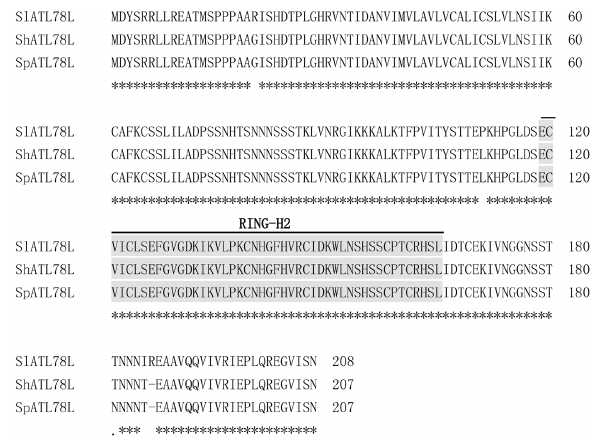
FIGURE 1 | Alignment of ATL78L amino acid sequences from Solanum lycopersicum cv. Ailsa Craig, S. habrochaites LA1777 and S. pennellii LA0716. The RING-H2 finger domain is shown in gray